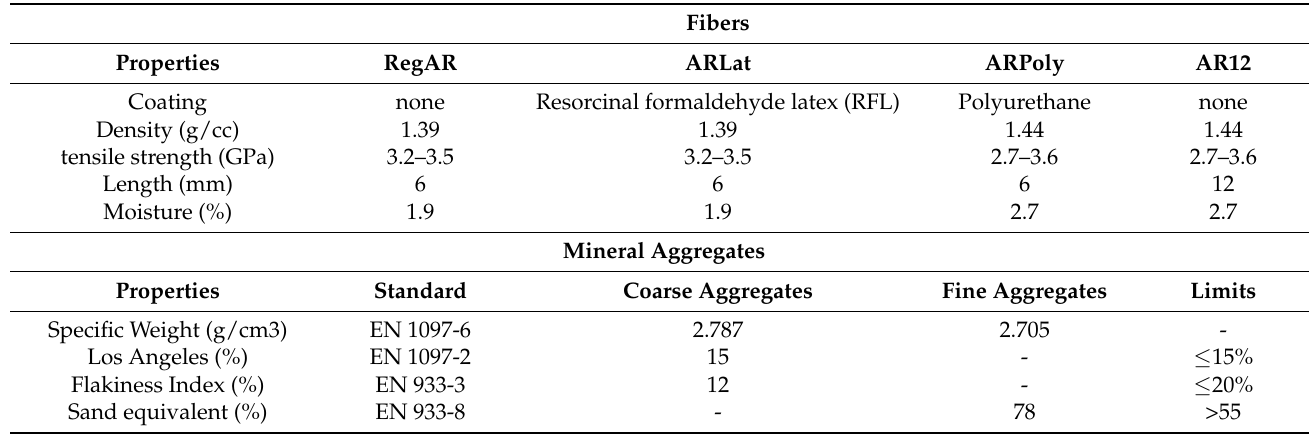
Table 2. Properties of fibers and aggregates used in the study.